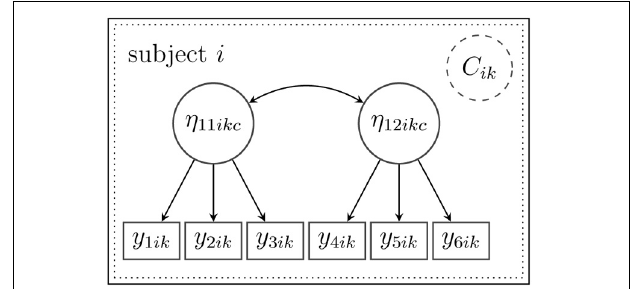
FIGURE 2 | A measurement model for subject i for two latent variables with a mixture distribution on the within-level (the between-level i th not included in this example). The mixture distribution is symbolized by the frame with dashed lines. It was assumed that all subjects belonged to one latent class D = 1 on the between-level so that the index d could be